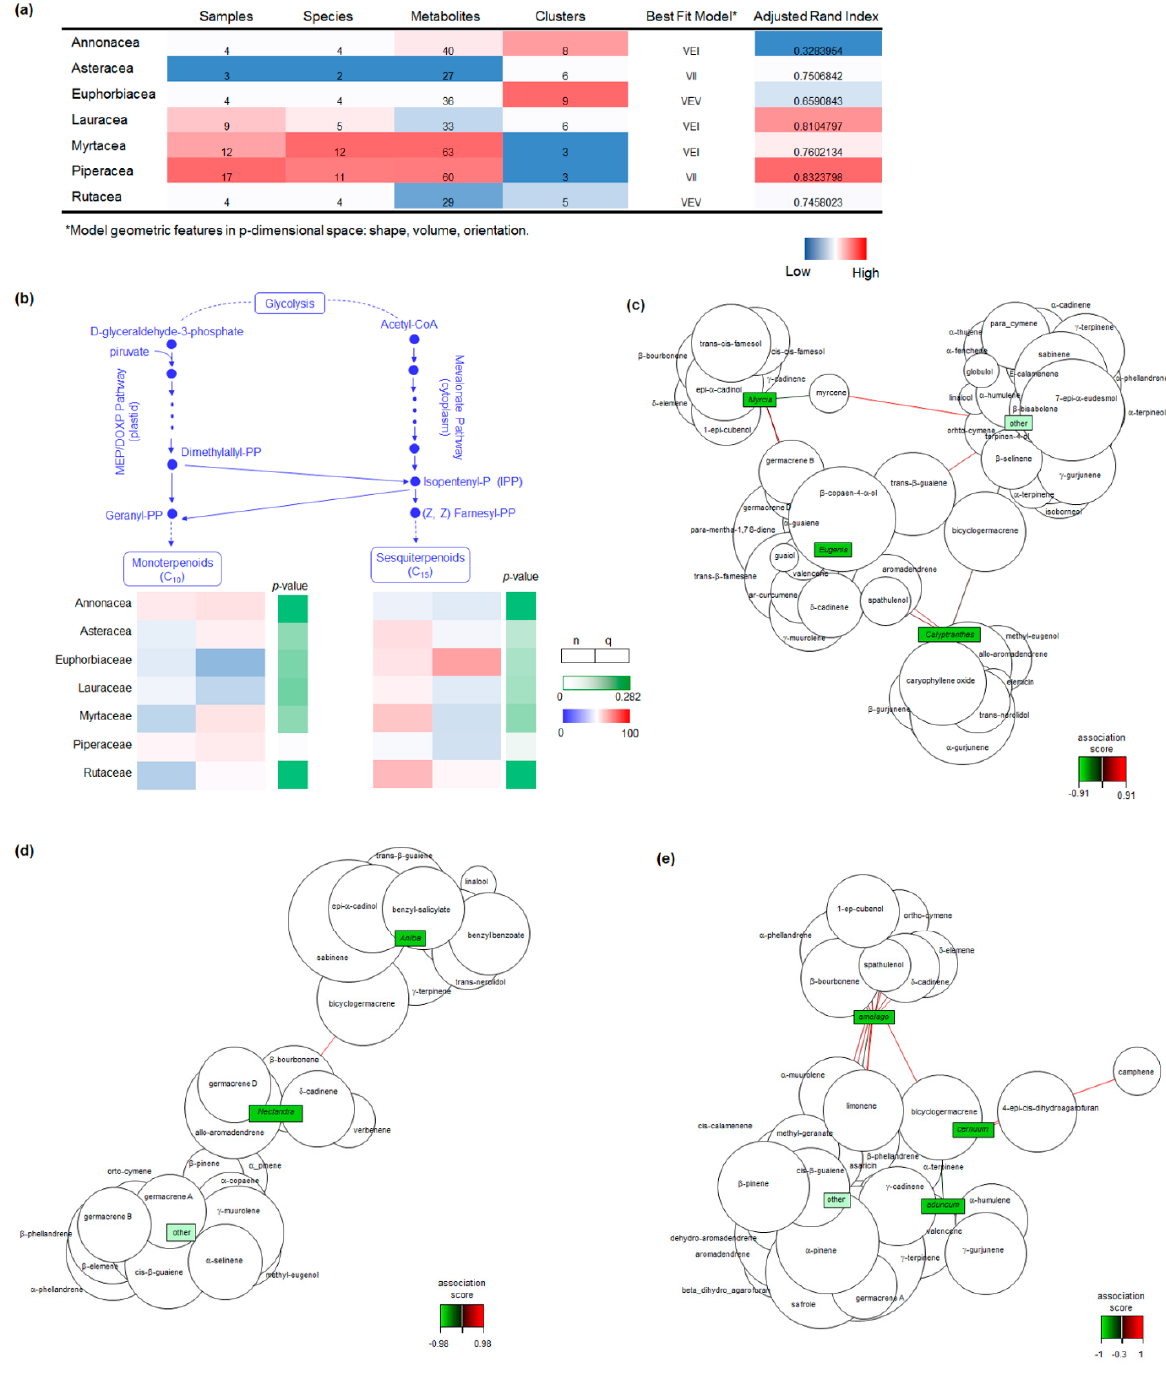
Figure 3. Chemical diversity of the EO composition within the most frequent botanical families. ( a ) Heatmap summary of GMMs of the EO chemical profiles of the most frequent botanical families.